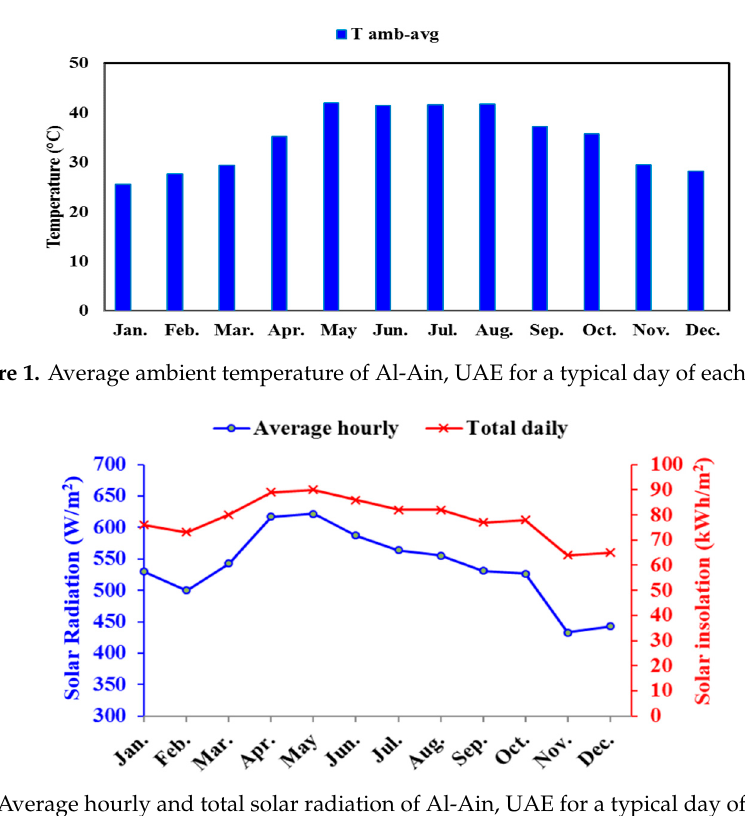
Figure 3. Required space cooling employing dry low-density polystyrene with constant (dashed bars) and variable (solid bars) thermal conductivity for residential buildings in hot climate of Al-Ain, UAE. 3.3. Yearly Energy Performance The total yearly average and peak additional energy demand for the air conditioning system to remove the heat from the space by percentage (additional space cool) were obtained for different levels of polystyrene density and different levels of moisture content, as shown in Figures 4 and 5, respectively.